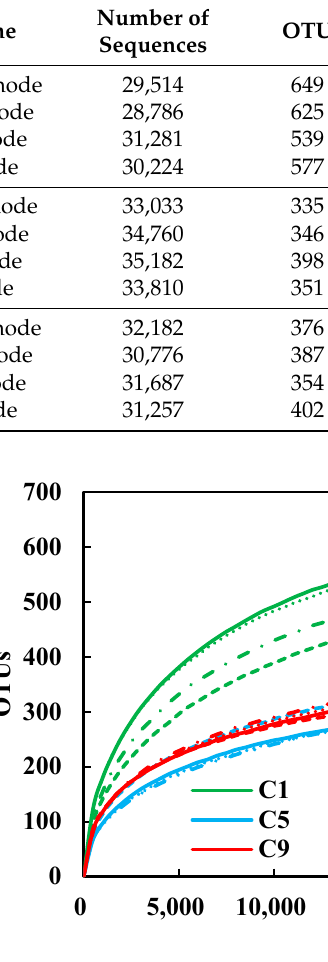
Figure 2. Rarefaction curves of the microbial communities.